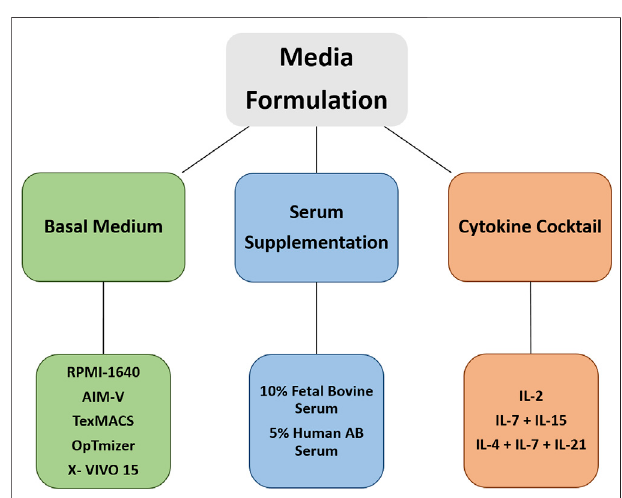
FIGURE 2 | Currently used media formulations for ex vivo expansion of CAR T